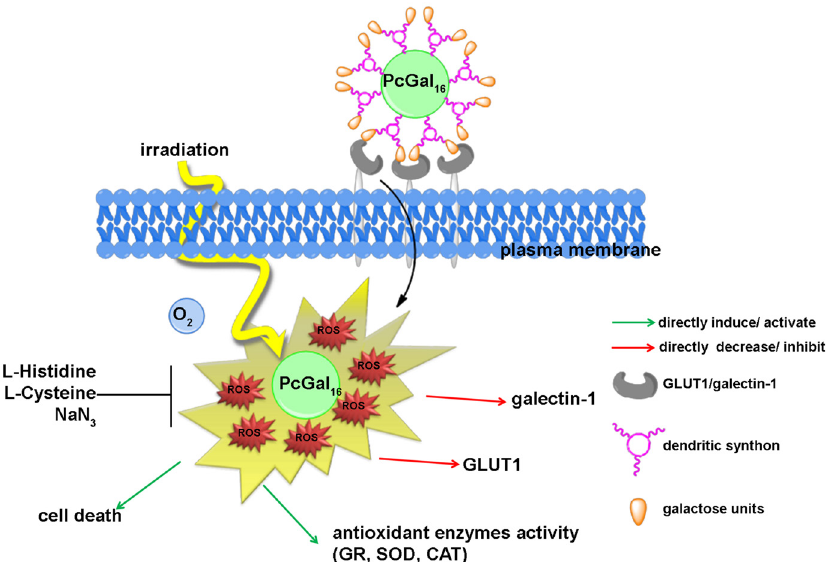
45 in human bladder cancer Figure 37 - Hypothetic illustration of phototoxicity of Pc-Gal 16 cells. The uptake of Pht-Gal 25 by bladder cancer cells is modulated by the presence 16 of carbohydrate-binding proteins present at the cell surface ( i.e . GLUT1 and galectin-1). Reproduced from Pereira et al. 2014b with permission of Public Library of